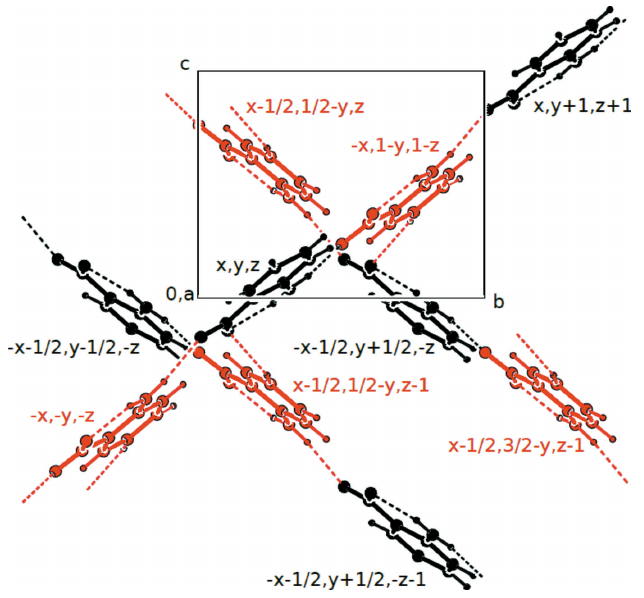
Figure 2 Hydrogen-bonded layers in the monoclinic structure.